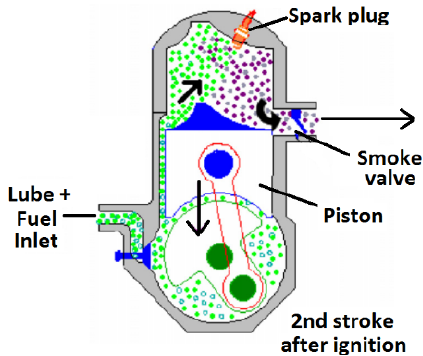
Figure 2. Lubrication with the help of the crank chamber in two-stroke engines and creation of smoke.